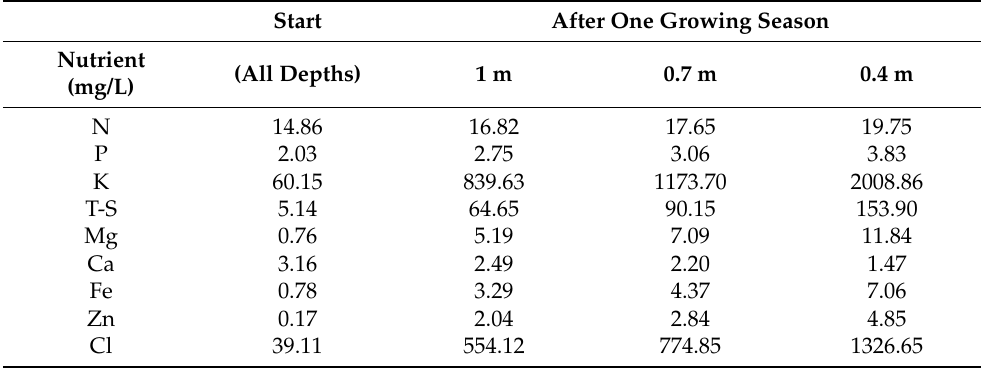
Table 2. The simulated nutrient concentrations of the different growth media were calculated using a non-linear solver technique. ‘Start’ = the composition of the growing medium of a continuous system at the start of the growing season; ‘1 m’/‘0.7 m’/‘0.4 m’ = the composition of the growing medium